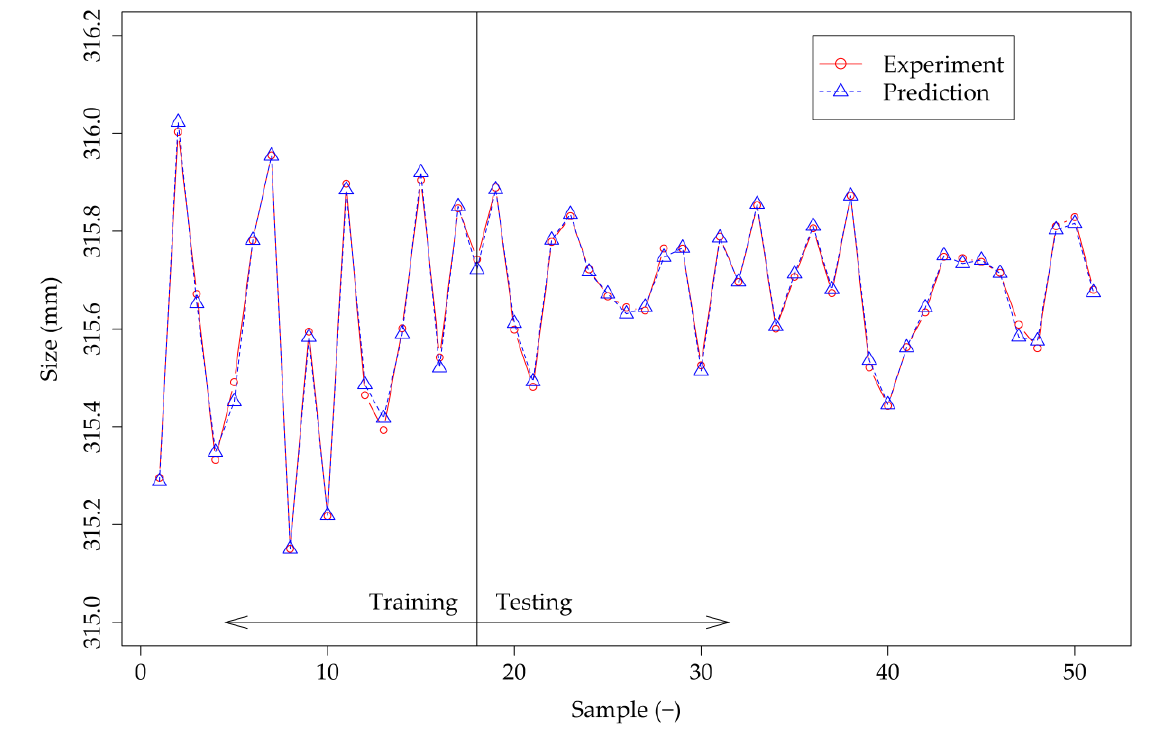
Figure 8. Comparison between prediction and experimental data for LMANN.